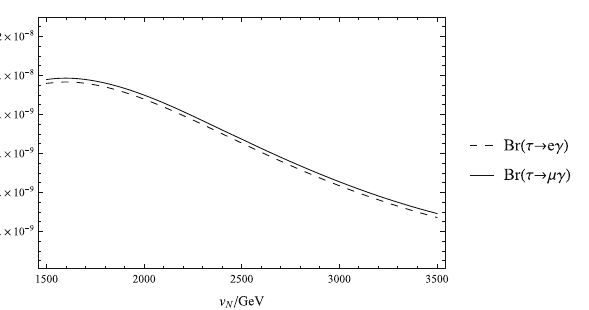
Fig. 11 The branching ratios of τ → e γ and τ → μγ versus param- eter v N are plotted by the dashed line and solid line respectively